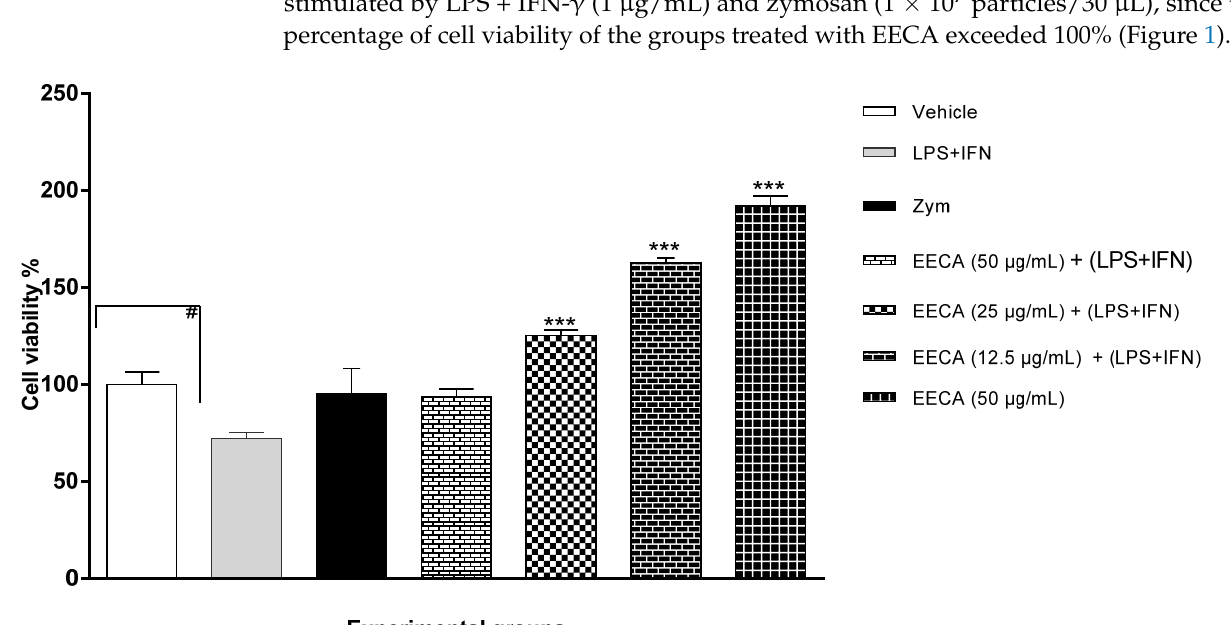
Figure 1. The effect of EECA on the cell viability of peritoneal macrophages stimulated by LPS + IFN- γ and zymosan. Data were obtained from at least three independent experiments and are summarized as mean ± SD. *** p < 0.001 indicates a significant difference between the group stimulated by LPS + IFN- γ (1 µ g/mL) and treated with EECA. # p < 0.1 represents a significant difference between the control group and the group stimulated by LPS + IFN- γ (1 µ g/mL). EECA: ethanolic extract of the rhizome of C. articulatus